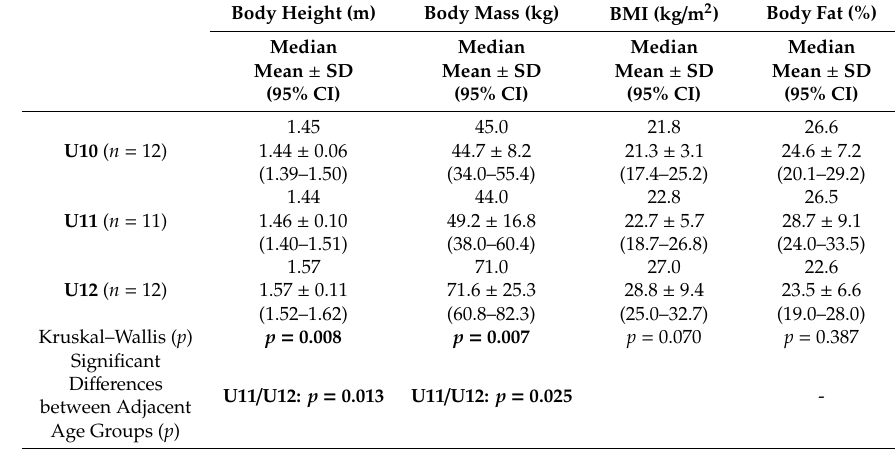
Table 2. Demographic and anthropometric characteristics in relation to age groups. Bold font denotes p < 0.05.